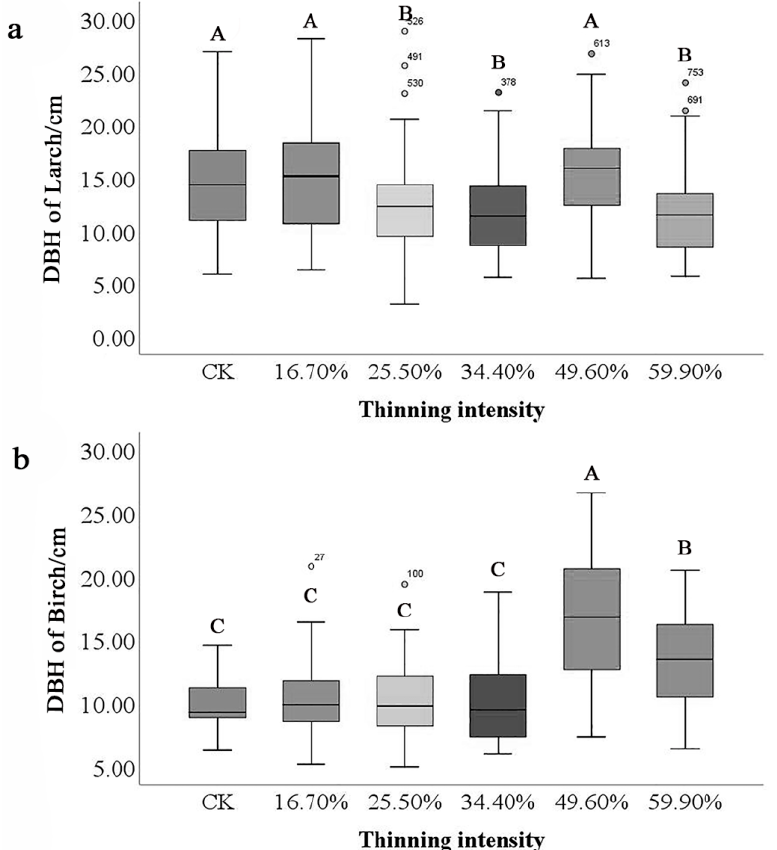
Figure 2. Differences in DBH of tree species. Note: The small letter ( a ) stands for DBH of larch and ( b ) stands for DBH of birch. Different capital letters in the same figure represent significant differences in DBH among the thinning groups ( p <